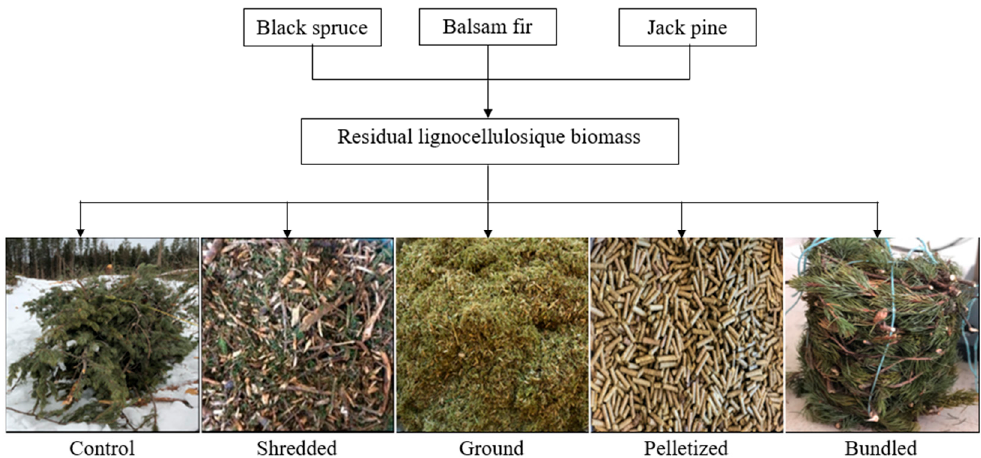
Figure 1. The different types of residual forest biomass preparation before the extraction of essential oils